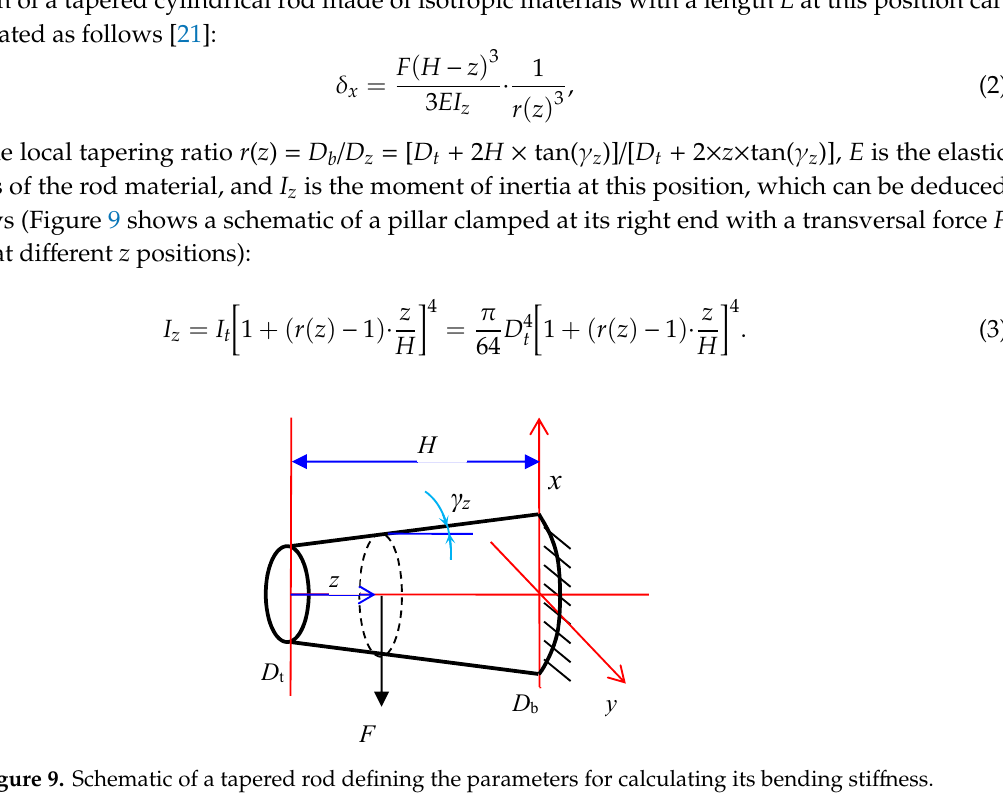
Figure 10. Measured profile and the bending stiffness of the pillar with respect to its axial positions. 0